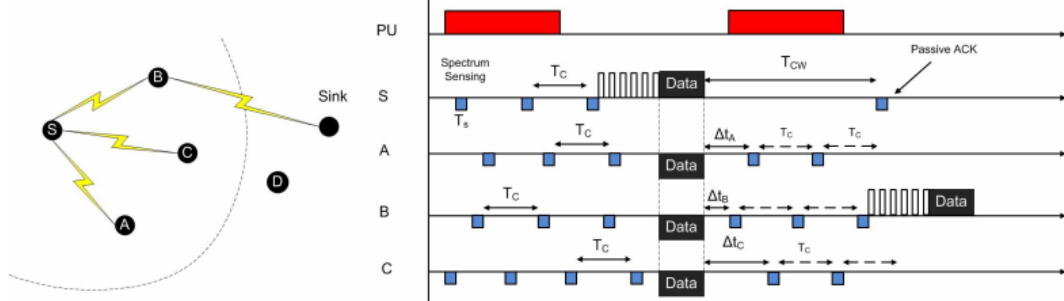
Figure 1 . Timeline of HCR-MAC protocol with an illustrated scenario of sender and receiver nodes